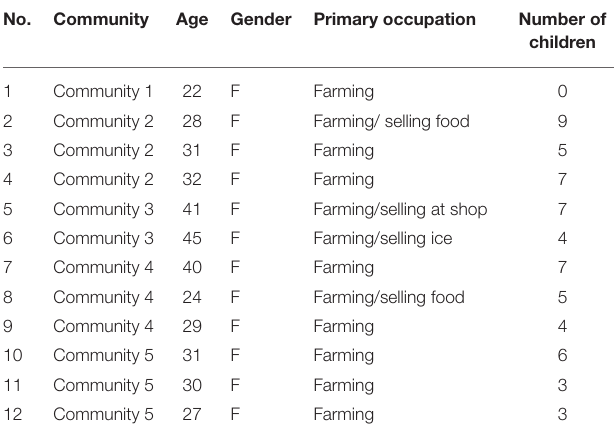
TABLE 2 | Demography of 12 study participants. No.